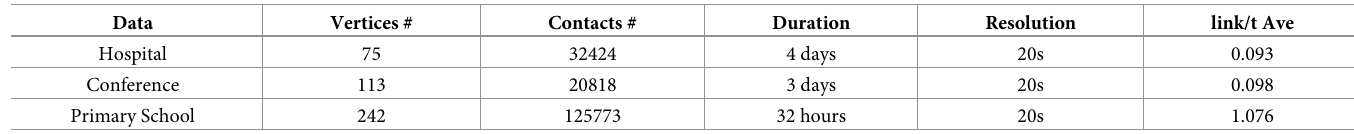
Table 1. Some characteristics of the three different empirical temporal networks: Hospital network, conference network and primary school network. The details of the data collection and metadata can be found respectively in